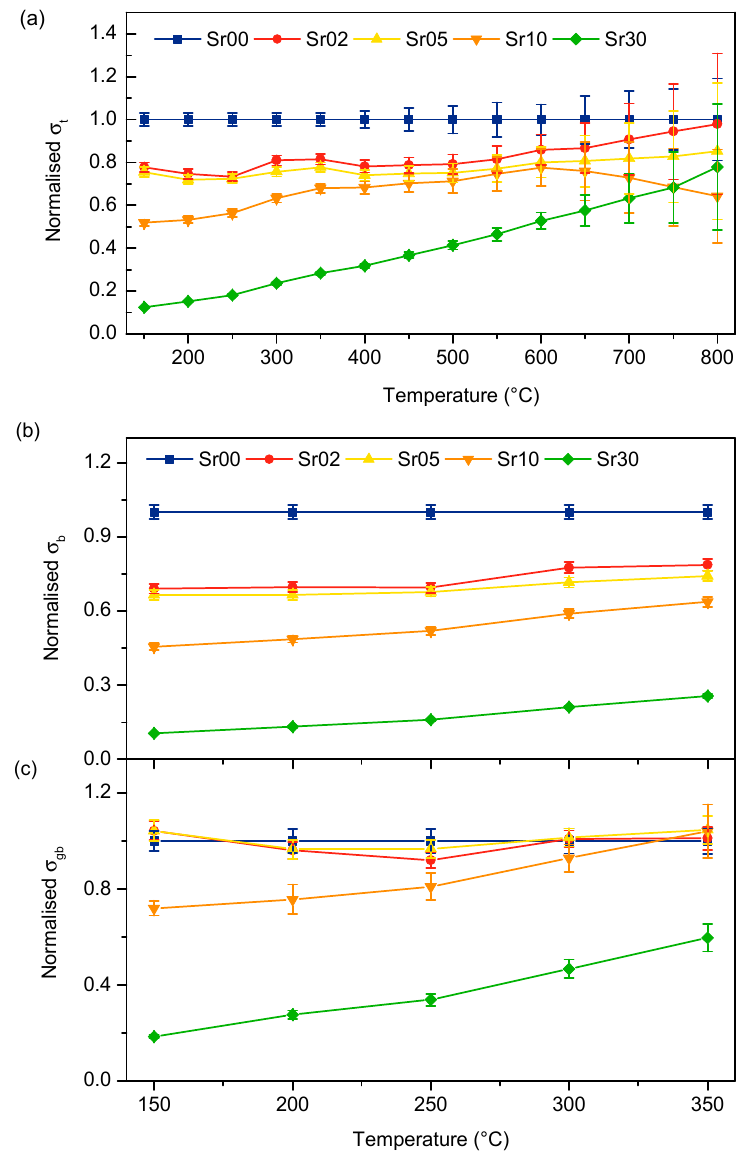
Figure 10. Normalised ( a ) total, ( b ) bulk and ( c ) grain boundary conductivity for the Ce 0.8 − x Sm 0.2 Sr x O 2 − δ samples indicated. Conductivity was normalised by dividing by the conductivity of the undoped sample (Sr00) at each temperature.